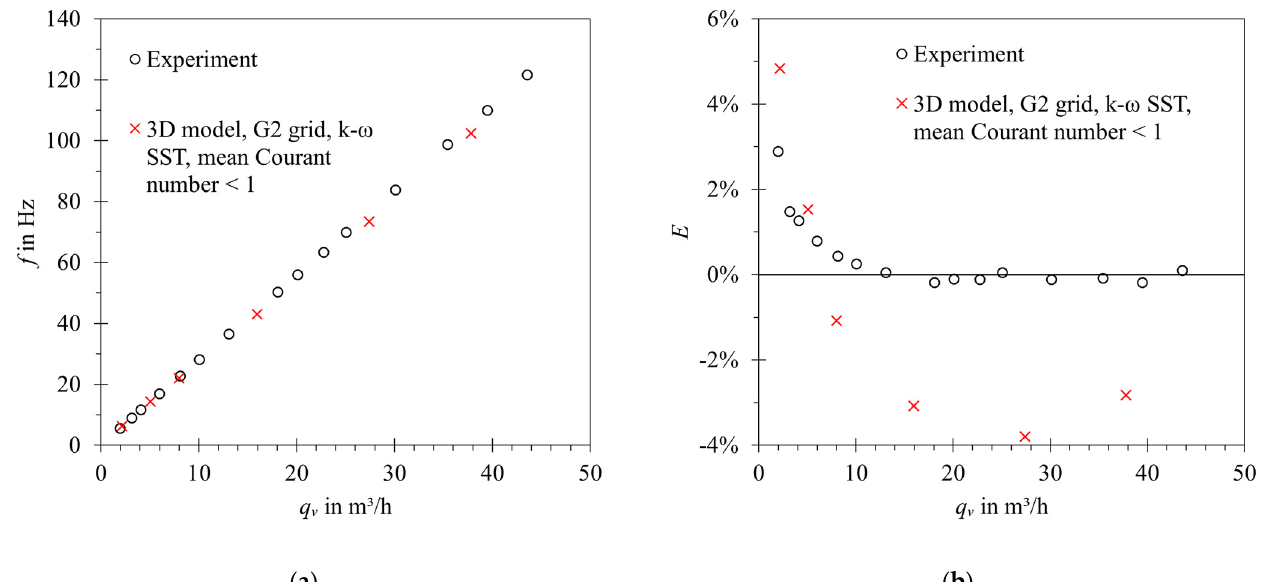
Figure 21. Validation of the three-dimensional model against experimental data of the flowmeter: ( a ) Frequency vs. volumetric flow rate; ( b ) error curves for K = 10,03 imp/dm 3 . Error bars denote experiment uncertainty for coverage factor k = 2.